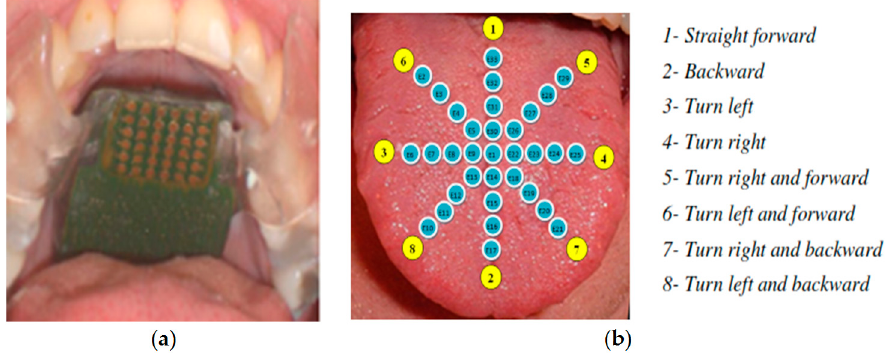
Figure 10. ( a ) Matrix of electrode; ( b ) Different eight directions for the matrix of electrodes [30].